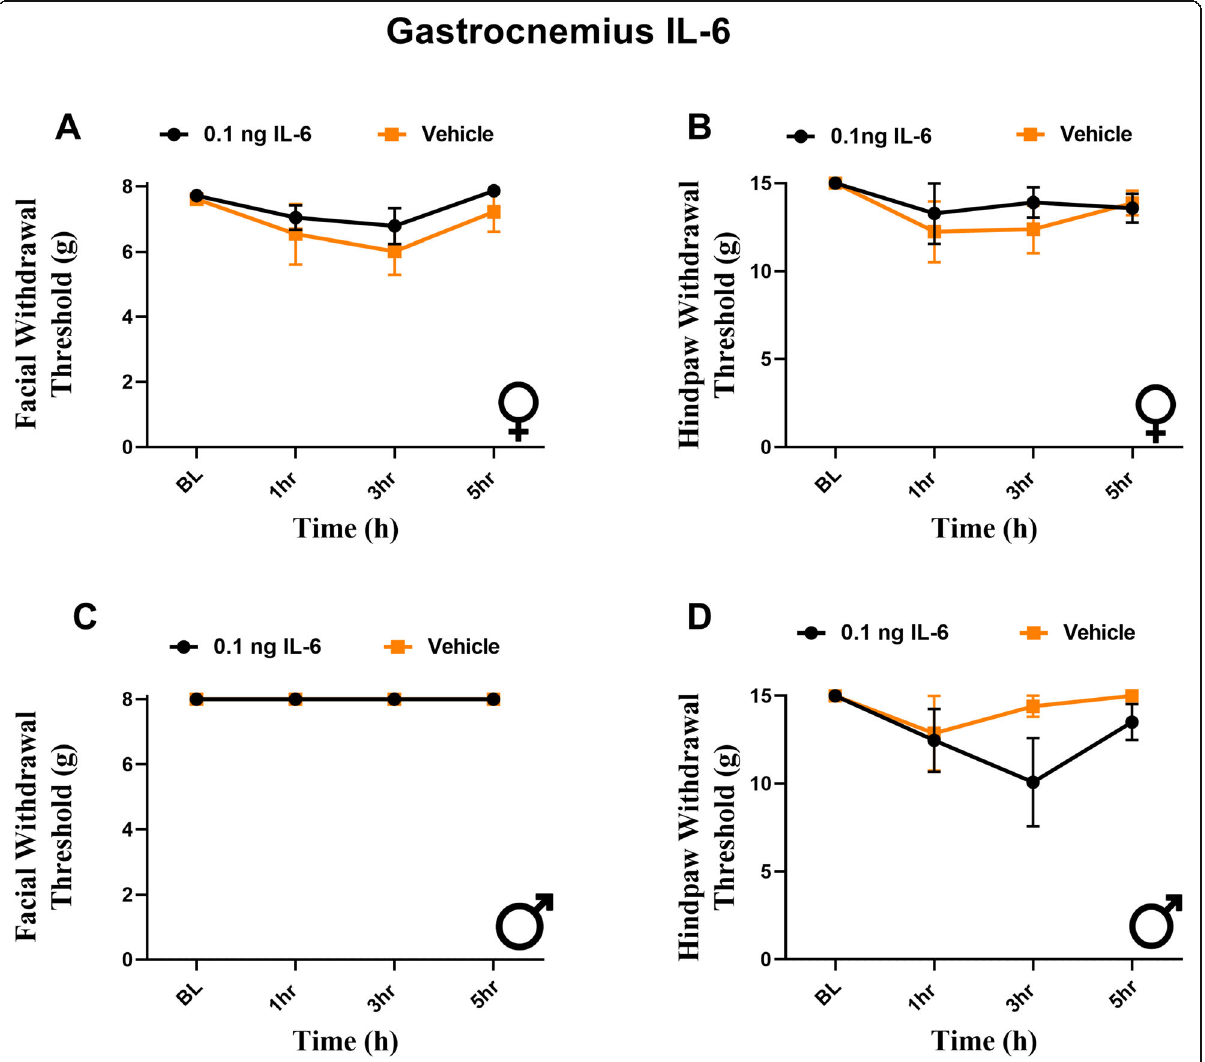
Fig. 5 Gastrocnemius injection of IL-6 produces no significant facial or hindpaw responses in male and female rats. Rats had facial and hindpaw withdrawal thresholds assessed prior to and following administration of 0.1 ng IL-6 (6 females, 6 males) or vehicle (6 females, 5 males) into the gastrocnemius muscle. Two-way ANOVA followed by Bonferroni posthoc analysis revealed no significant effect of treatment on facial or hindpaw responses in female ( A , B ) (F (1, 40) = 1.844, p = 0.1821) (F (3, 36) = 0.2904, p = 0.8320) or male ( C , D ) (no variation among groups) (F (1, 36) = 2.289, p = 0.1390)